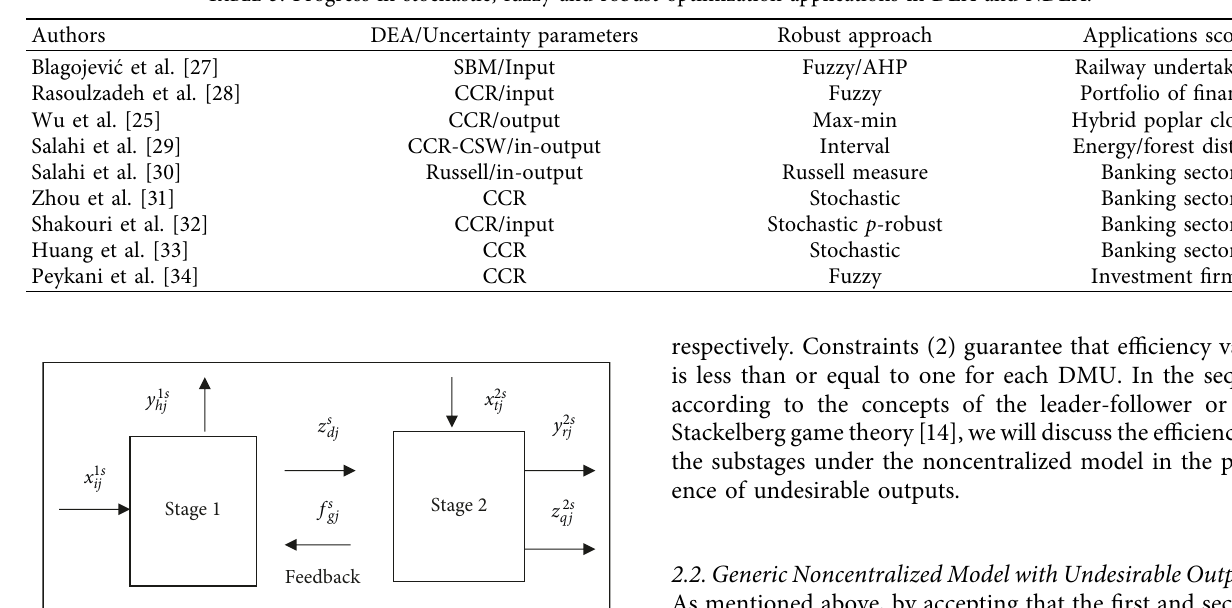
Table 3: Progress in stochastic, fuzzy and robust optimization applications in DEA and NDEA.